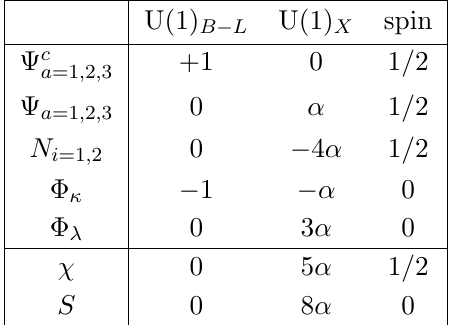
Table 7 . Beyond the SM (cid:12)elds and their charges under new gauge symmetries U(1) B (cid:0) L Here (cid:11) is some arbitrary real